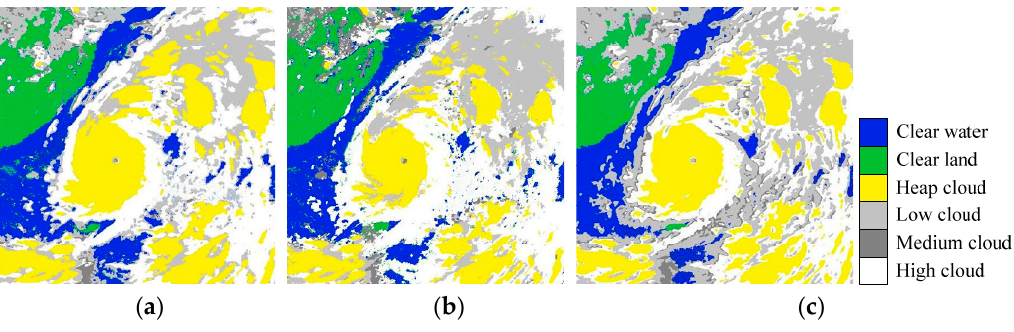
Figure 7. Cloud classification results by FSVM, CCSI-ODSR, and AFSRC. ( a ) FSVM; ( b ) CCSI-ODSR; ( c ) AFSRC.